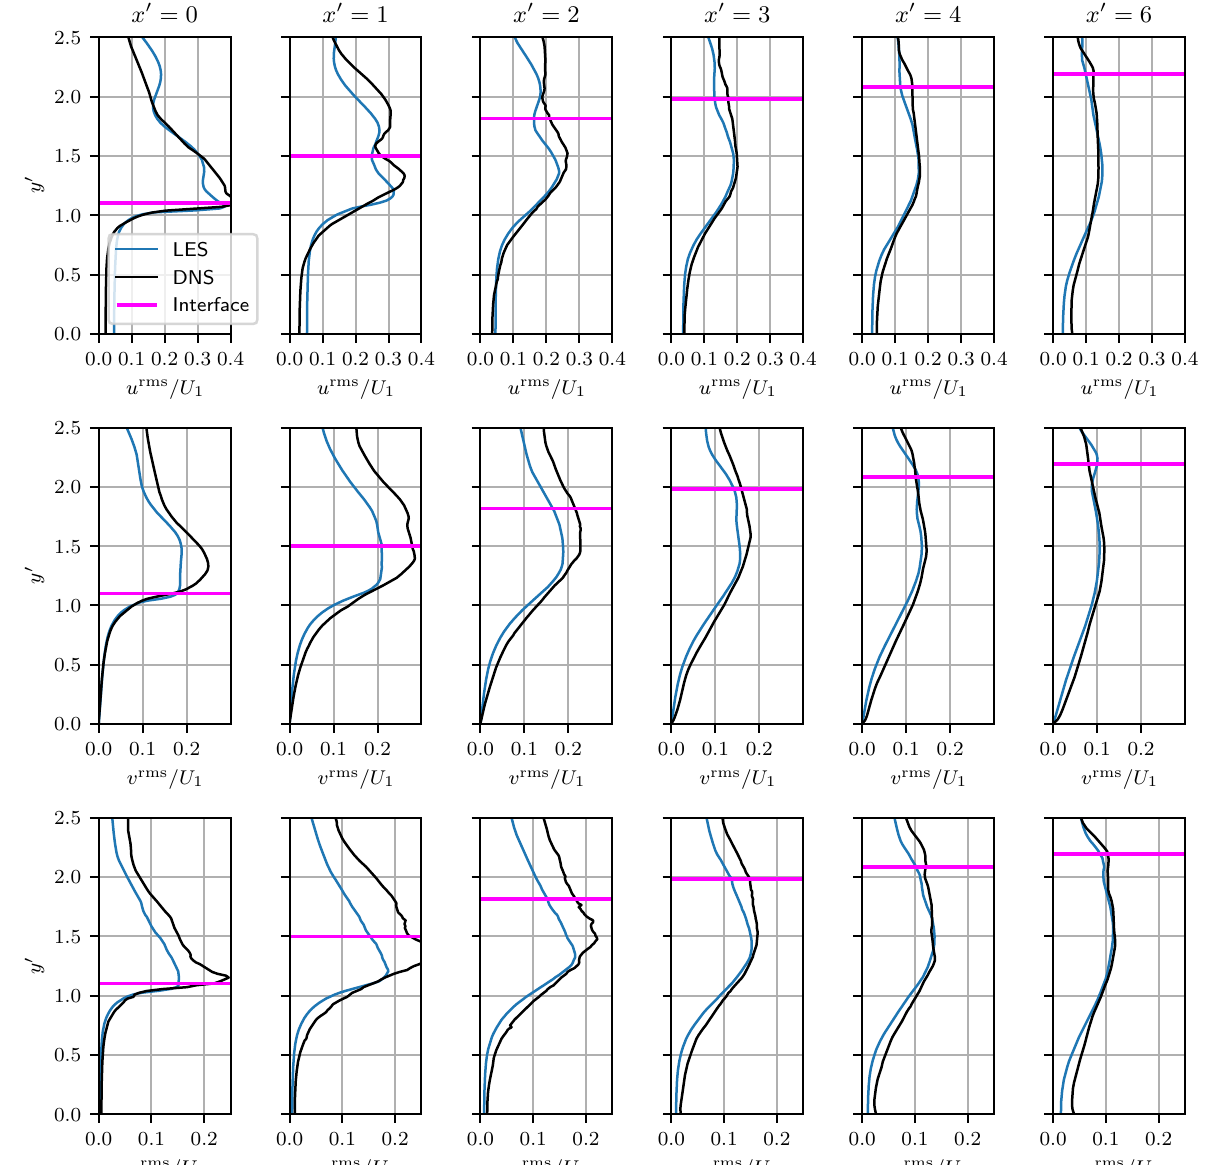
Figure 7. The profiles of u rms / U 1 , v rms / U 1 , and w rms / U 1 obtained in the benchmark simulation. The magenta line shows the location of the